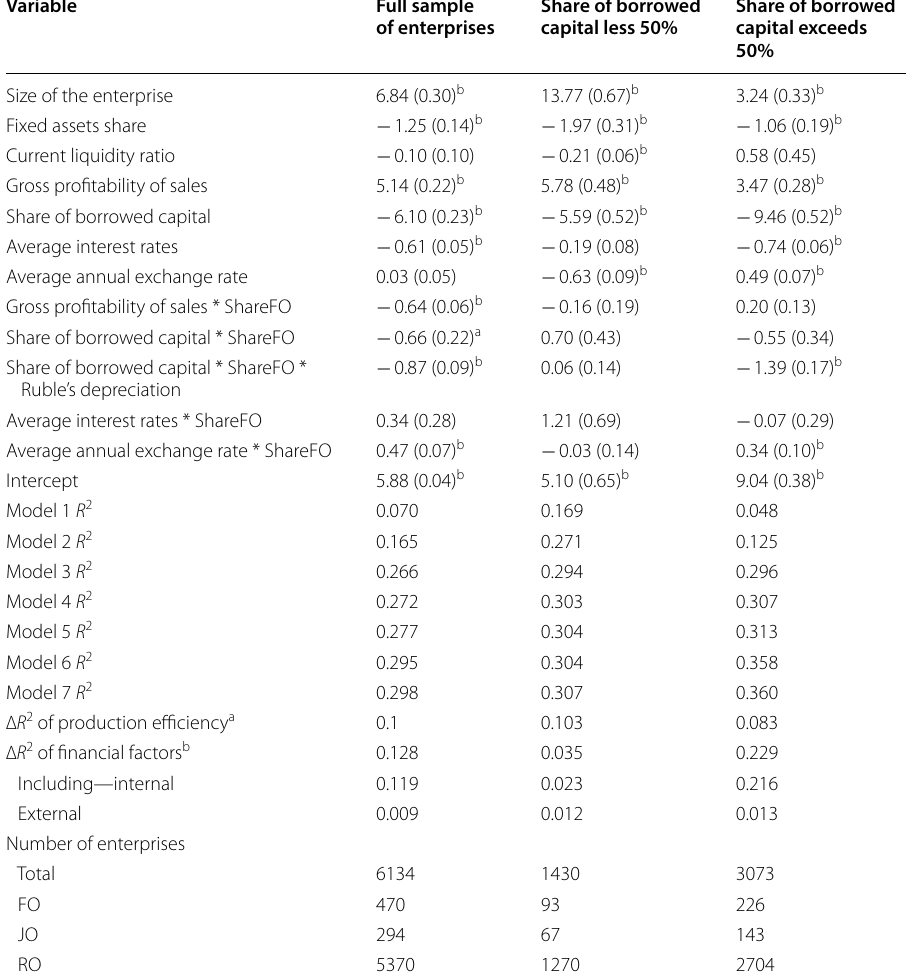
Standard errors are in parentheses. The coefficients and standard errors are given according to model 7. All constructed models (models no. 1–7) are highly significant for all samples ( p ≪